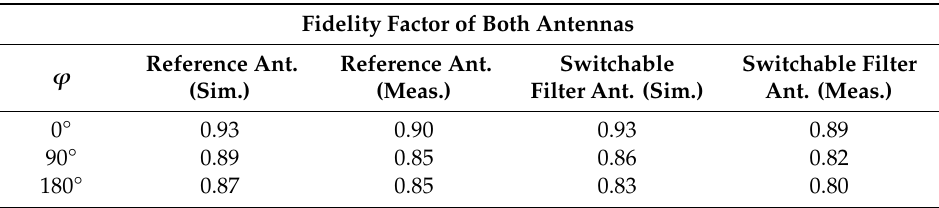
Table 1. Fidelity factor of the reference and switchable filter antennas.